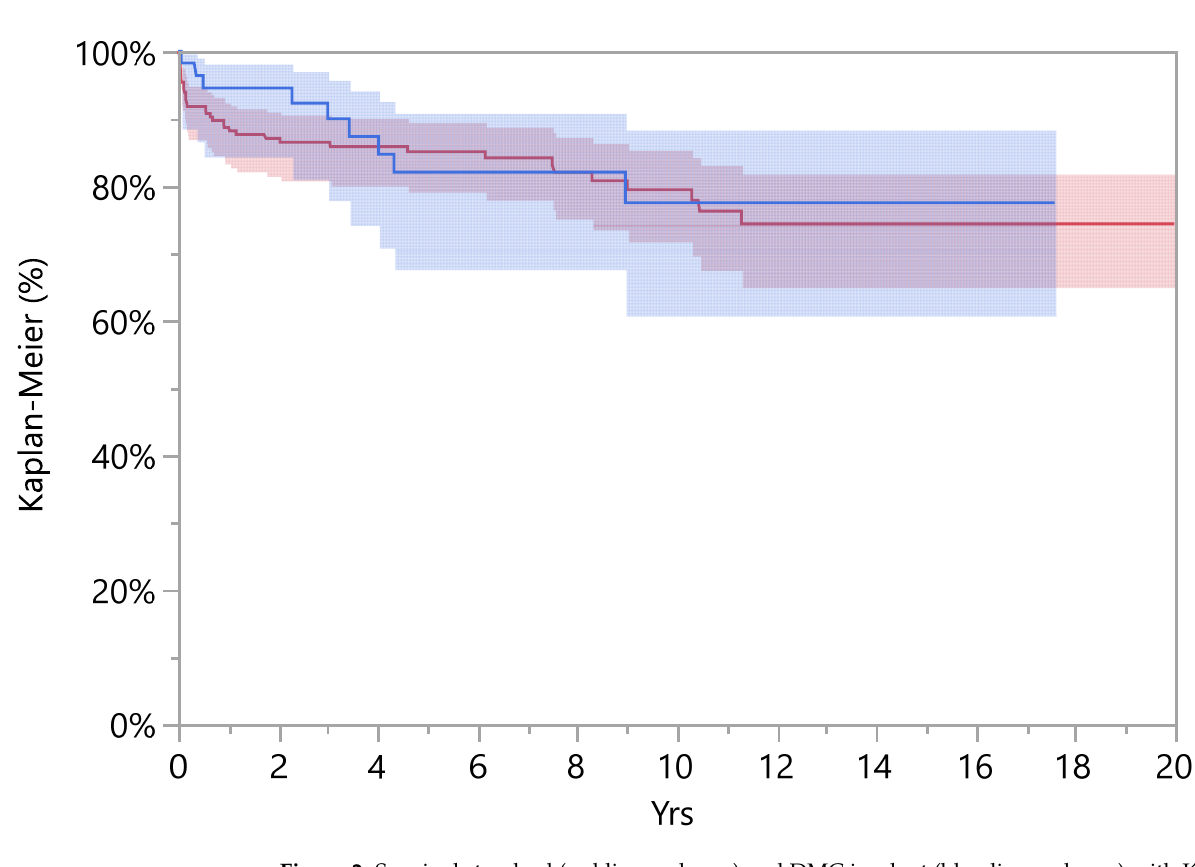
Figure 2. Survival standard (red line and area) and DMC implant (blue line and area) with Kaplan– Meier (%) diagram. Table 4. Overall survival of Standard Cups and DMC.